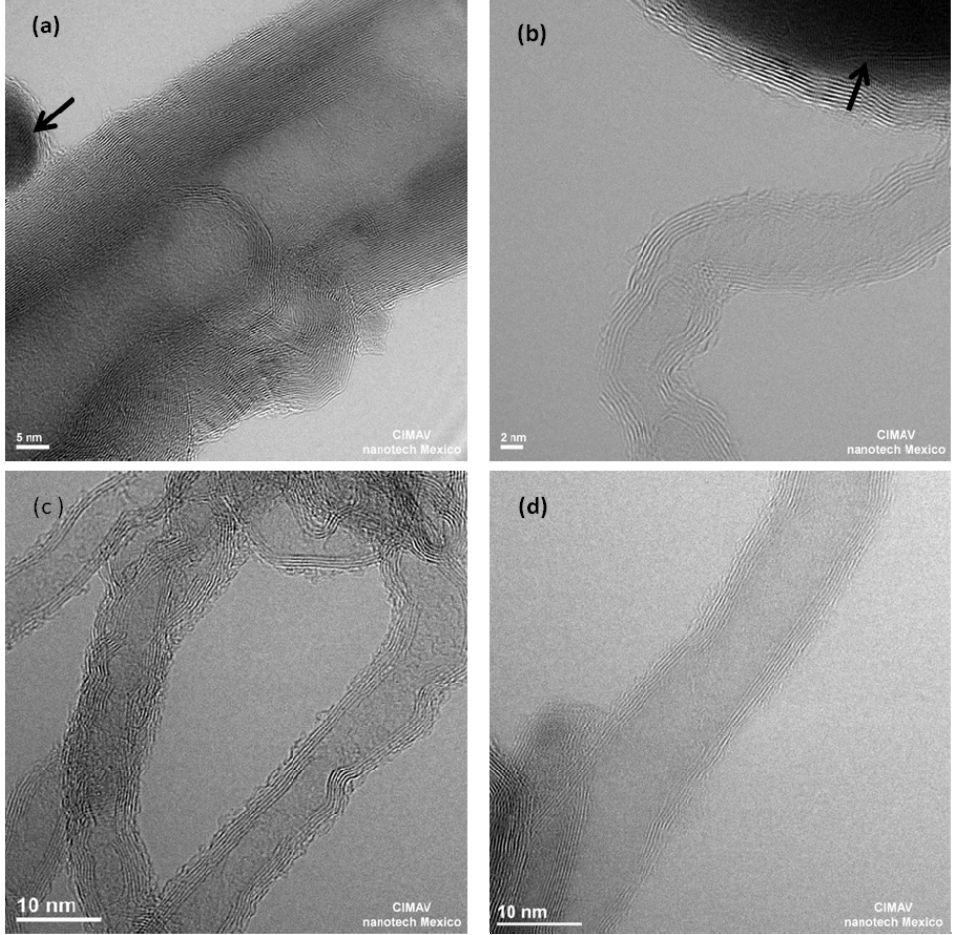
Figure 3. TEM images of carbon nanotubes obtained from: ( a ) Methanol; ( b ) Ethanol; ( c ) Propanol and ( d ) Butanol. Arrows indicate iron nanoparticles and carbon encapsulated